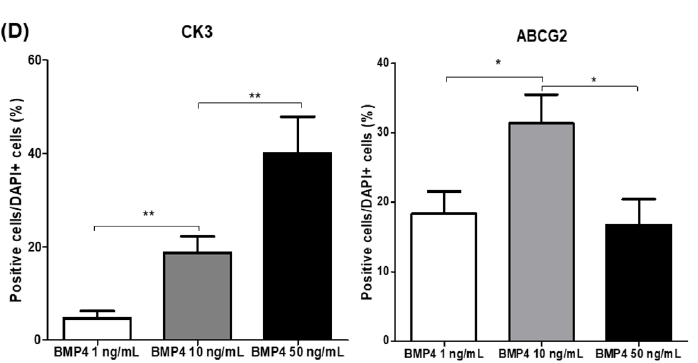
Figure 5. Immunohistochemical analysis of human iPS cells, differentiated with indicated concen- trations of BMP4. Limbal-specific medium with 10 ng/mL BMP4 induced more limbal progenitor cells (ABCG2+, arrow) and less corneal epithelial cells (CK3+, arrowhead) on the differentiation from human iPS cells ( B ) than 1 ng/mL ( A ) or 50 ng/mL ( C ) BMP4. Images represent 3 or 4 independent experiments. Scale bar = 10 µ m. ( D ) Graphs represent ≥ 3 independent experiments, and data are presented as means ± standard deviation (* p < 0.05; ** p <